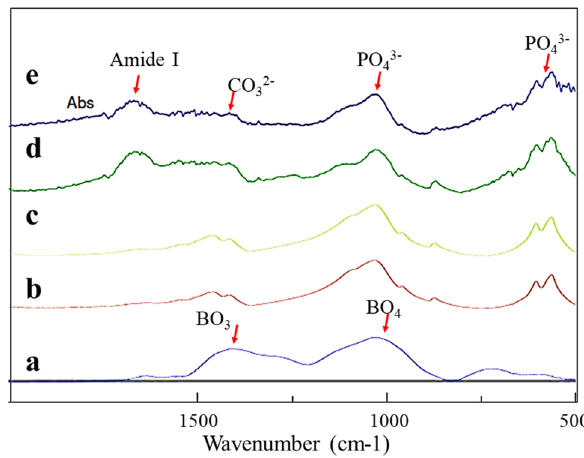
Figure 2. Representative FTIR spectra for the tested specimens, ( a ) S-PRG fillers, ( b ) untreated enamel (control), ( c ) S-PRG treated enamel, ( d ) untreated dentin (control), ( e ) S-PRG treated dentin. The peaks centered at 1067 and 1375 are corresponding to BO 4 and BO 3, respectively.